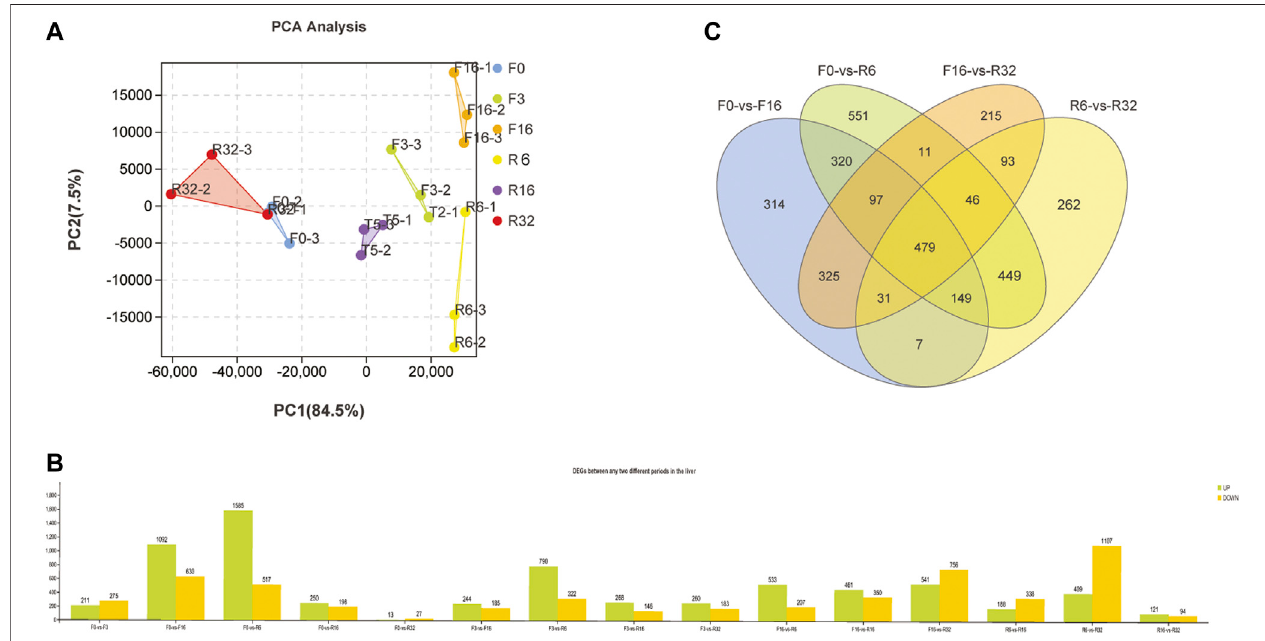
FIGURE 1 | Transcriptome analysis of the liver in six periods during IM. (A) PCA analysis was used to understand the repeatability of samples in each period of IM. (B) Overall statistics of signi fi cantly different genes in each comparison group: green represents upregulation; yellow represents downregulation. (C) Difference Venn diagram of the relative comparison